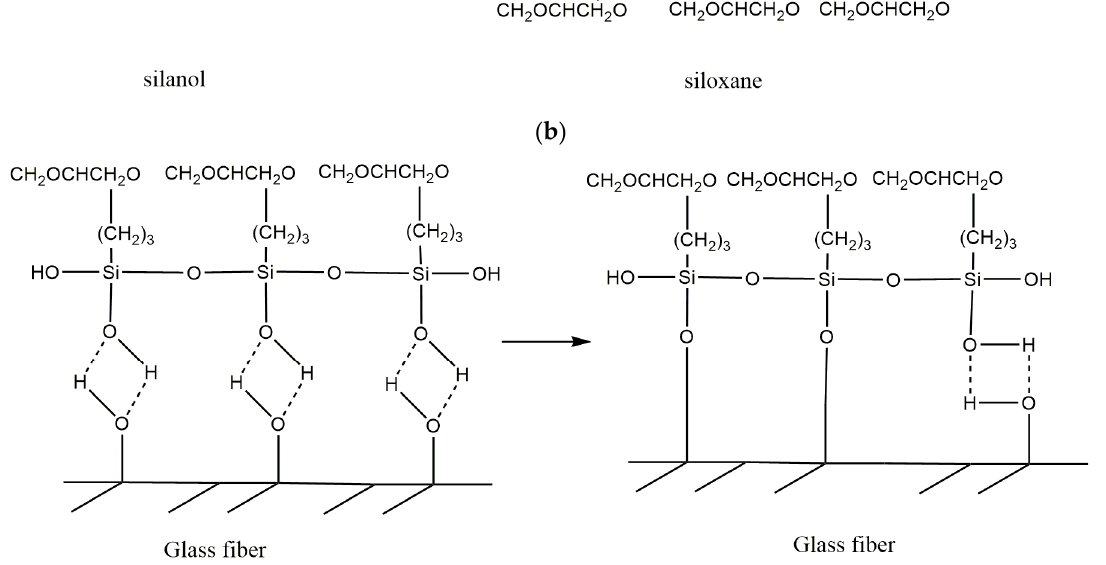
Figure 6. Treatment principle of silane coupling agent KH560. ( a ) Silane coupling agent hydrolysis. ( b ) Polycondensation to form oligomeric siloxane. ( c ) Oligosiloxane and glass fabric lose water to form a covalent bond.